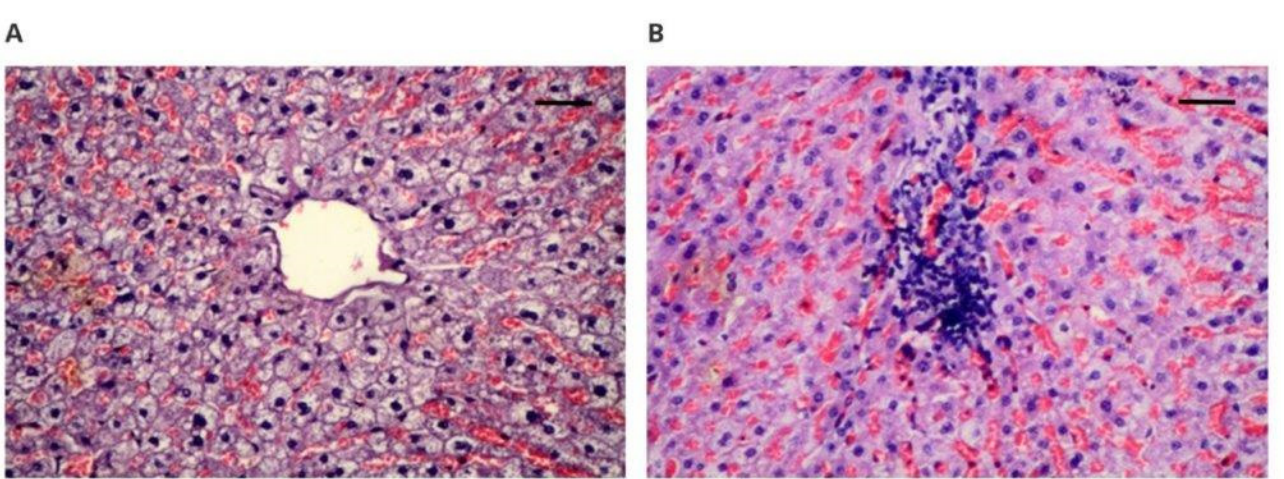
Figure 3. Microscopically assessed image of the heart muscle obtained from implanted animals: ( A ) ( A ) 100 × magnification (scale bar 100 µ m), hematoxylin–eosin staining magnification; ( B ) 100 × 100× magnification (scale bar 100 µm), hematoxylin–eosin staining magnification; ( B ) 100× magnifi- magnification (scale bar 100 µ m), Masson’s staining. cation (scale bar 100 µm), Masson’s staining.